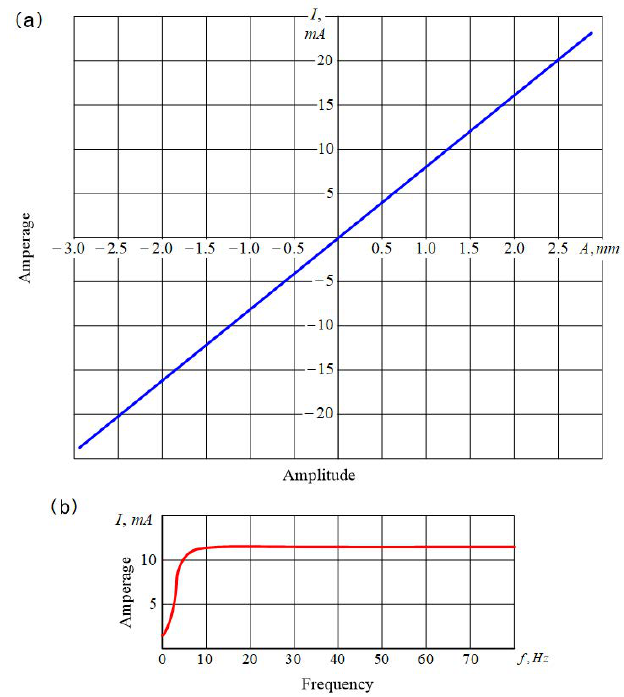
Figure 3. Characteristics of the elements of the block diagram: ( a ) Static characteristics of the primary transducer, ( b ) the amplitude-frequency characteristics of the primary